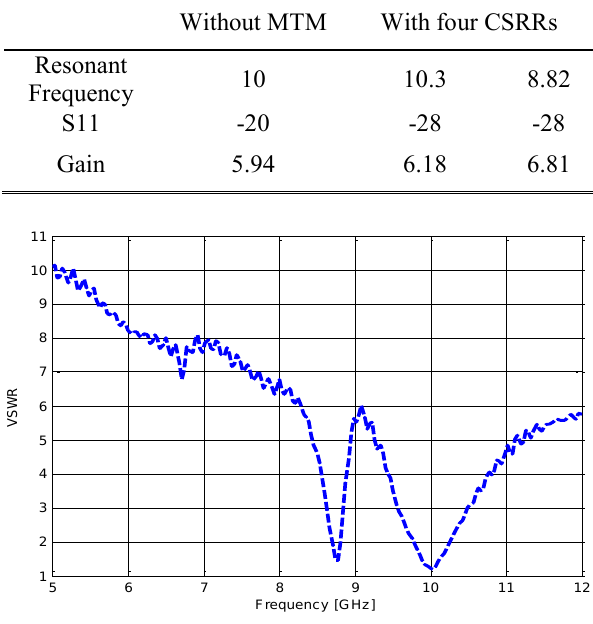
Figure 11: Measured SWR of the proposed